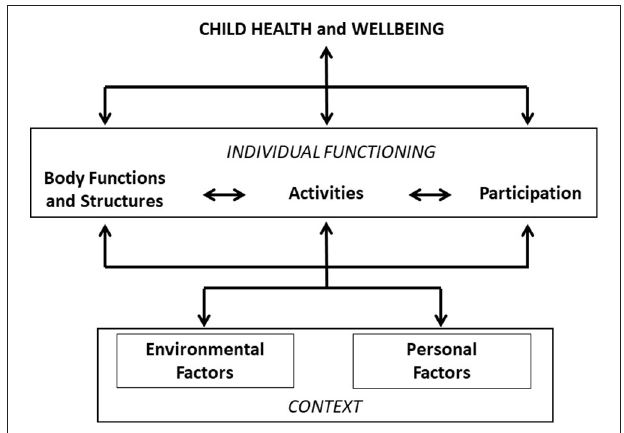
FIGURE 1 | The interactive ICF-CY model, adapted from WHO (2007) for use with children (Björck-Åkesson, 2018). The figure is reproduced with the permission of the copyright